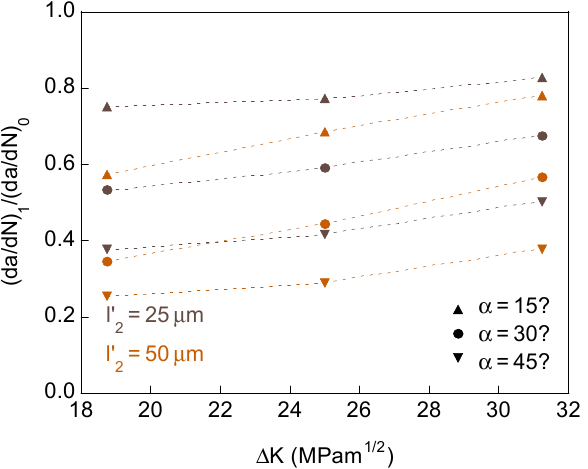
Figure 8. Retardation factor at the long-branch tip as a function of the SIF range for bifurcated crack tip with different initial projected length in the two branches.